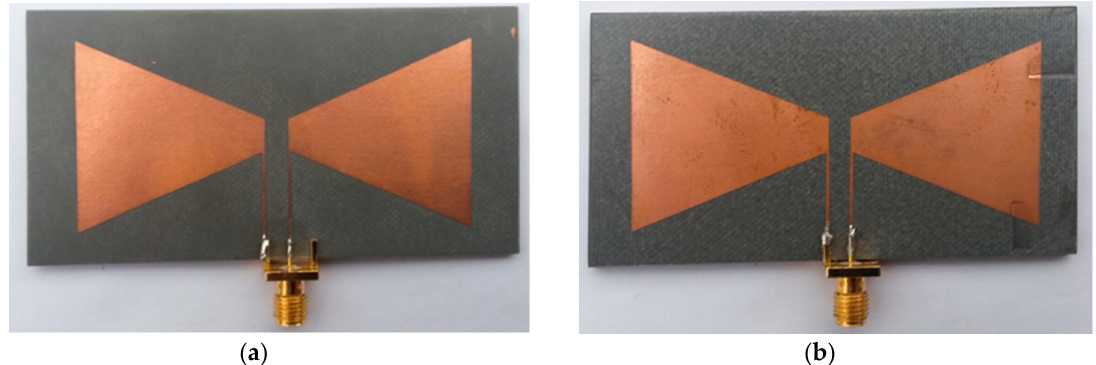
Figure 4. Fabricated bow-tie ( a ) antenna A with a thickness of 1.57 mm and 0.508 mm, ( b ) antenna B with a thickness of 3.175 mm and 1.27 mm.